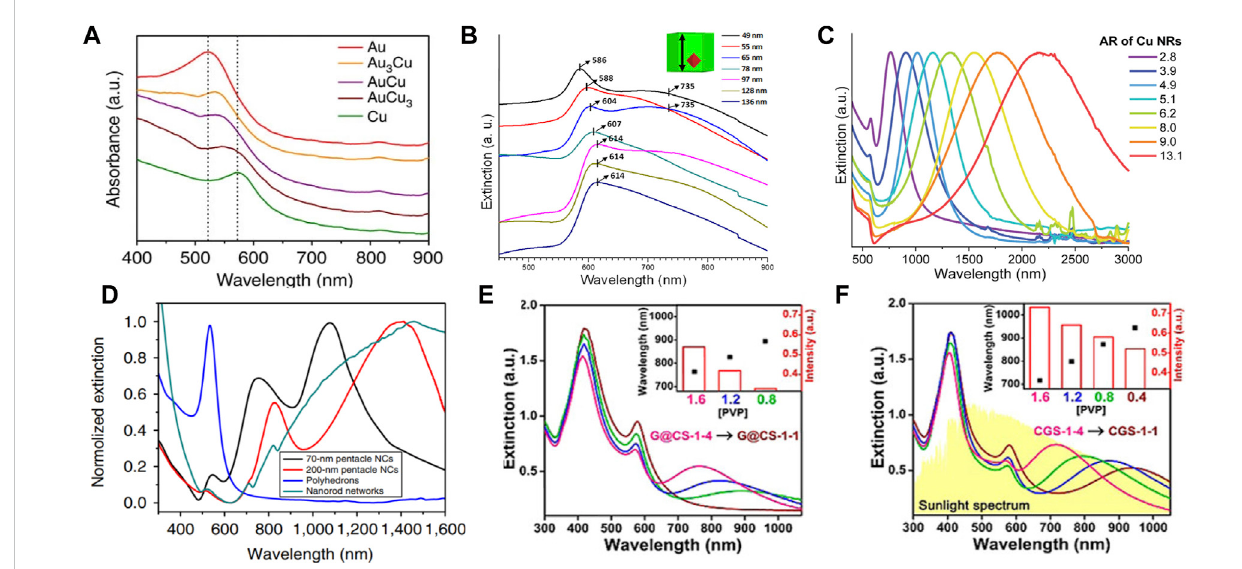
FIGURE 4 (A) Extinction spectra of Au nanospheres, Au – Cu alloy nanospheres and Cu nanospheres. Dotted lines indicate the LSPR peak of Au (~520 nm) and Cu (~570 nm) nanostructures (Kim et al., 2014). (B) Extinction spectra of Au – Cu core-shell cubes (Hsia et al., 2016). (C) Extinction spectra of Au – Cu NRs with different aspect ratios (Jeong et al., 2020). (D) Extinction spectra of Au – Cu alloy nanopentacles with different sizes (He et al., 2014). (E) and (F) Extinction spectra of Au – Cu – Ag nanostructures (G@CS-1 and CGS-1) with different concentrations of PVP(Lin et al.,